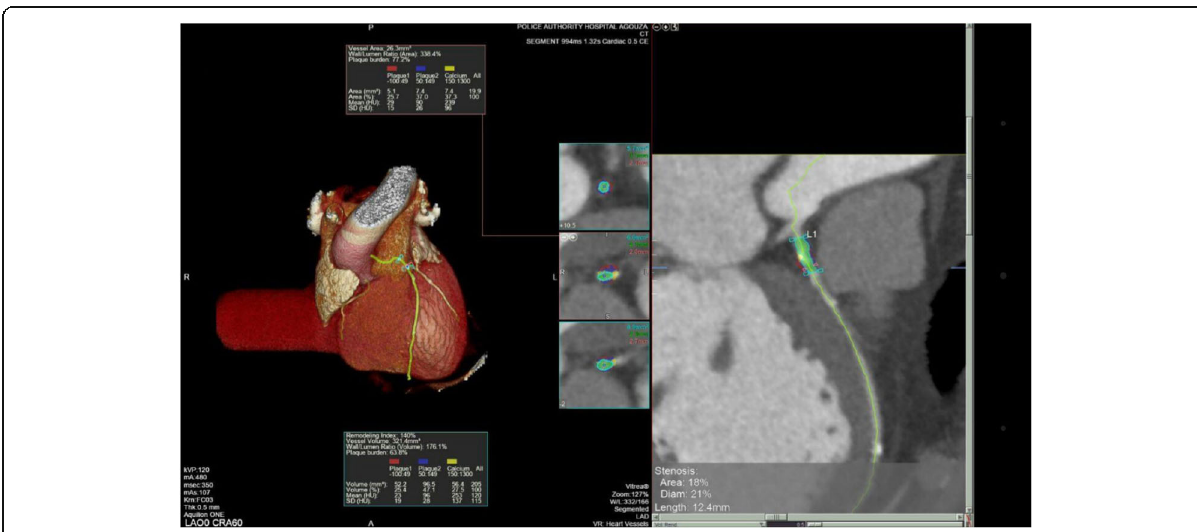
Fig. 1 MSCT angiography coronary of a male patient, a 42-year-old smoker, and complaining of chest pain: HbA1c was 11, cholesterol level was 249, TGS 250, HDL 35, and LDL 100. CT angiography shows the proximal LAD lesion with remodeling index 1.4%, plaque burden 77.2%, wall lumen ratio 338.4%, stenosis area 18%, stenosis diameter 21%, and stenosis length 12.4